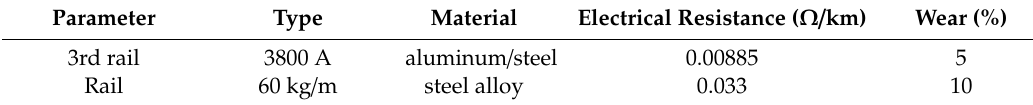
Table A4. Metro train supply system input parameters.